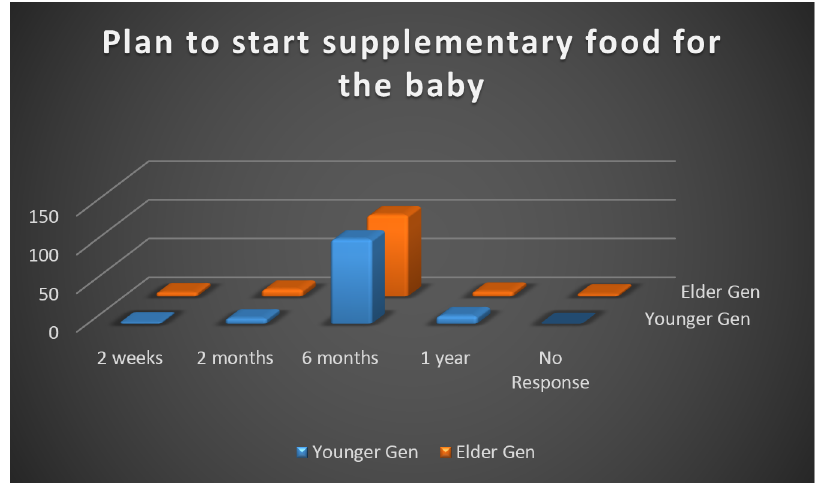
Fig 3. Responses obtained from the two groups when asked about the plan to start weaning (supplementary food) for the baby.